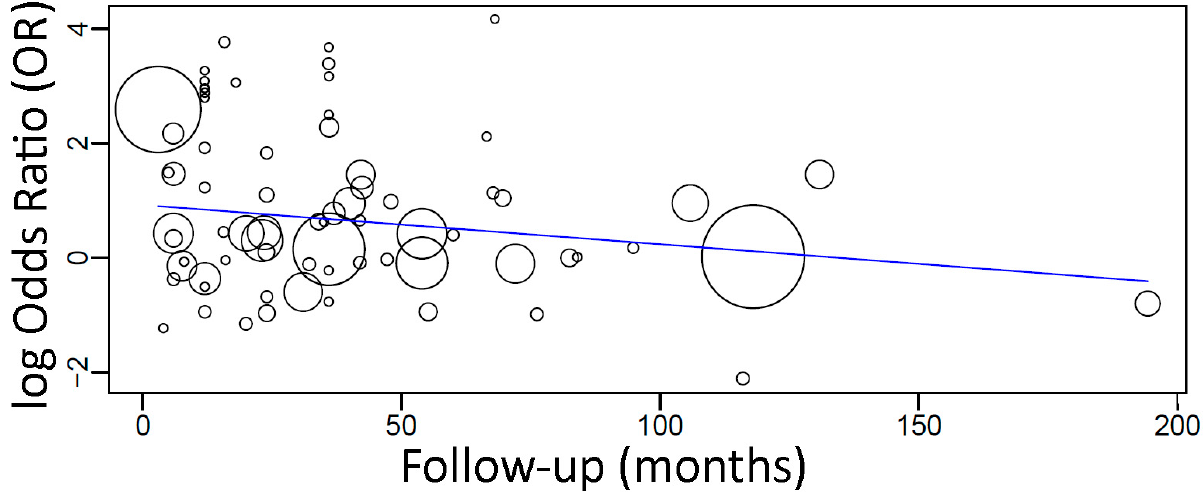
Figure 7. Scatter plot for the meta-regression with the association between the odds ratio (OR) of implant failure between diabetic and non-diabetic individuals, and the follow-up time (in months). Every circle represents a study and the size of the circle represents the weight of the study in the analysis.